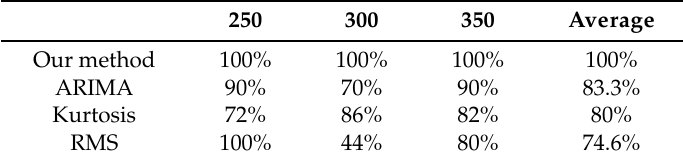
Table 5. Results of speed condition change detection by different setting initial speeds ν